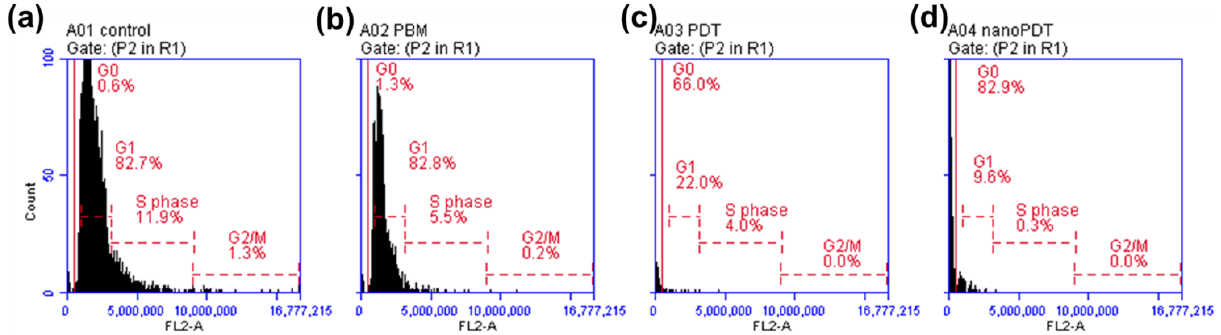
Figure 6. Cell cycle analysis through DNA quantification using flow cytometry of lung epithelial carcinoma cells (A549) 24 h post-PDT treatment: ( a ) Control cells receiving no treatment. ( b ) Cells receiving PBM of 10 J/cm 2 with a wavelength of 660 nm. ( c ) Cells receiving PDT treatment using 20 µM AlPcS4Cl and 10 J/cm 2 irradiation. ( d ) Cells receiving nanoPDT treatment using the AlPcS 4 Cl- goldnano bioconjugate.